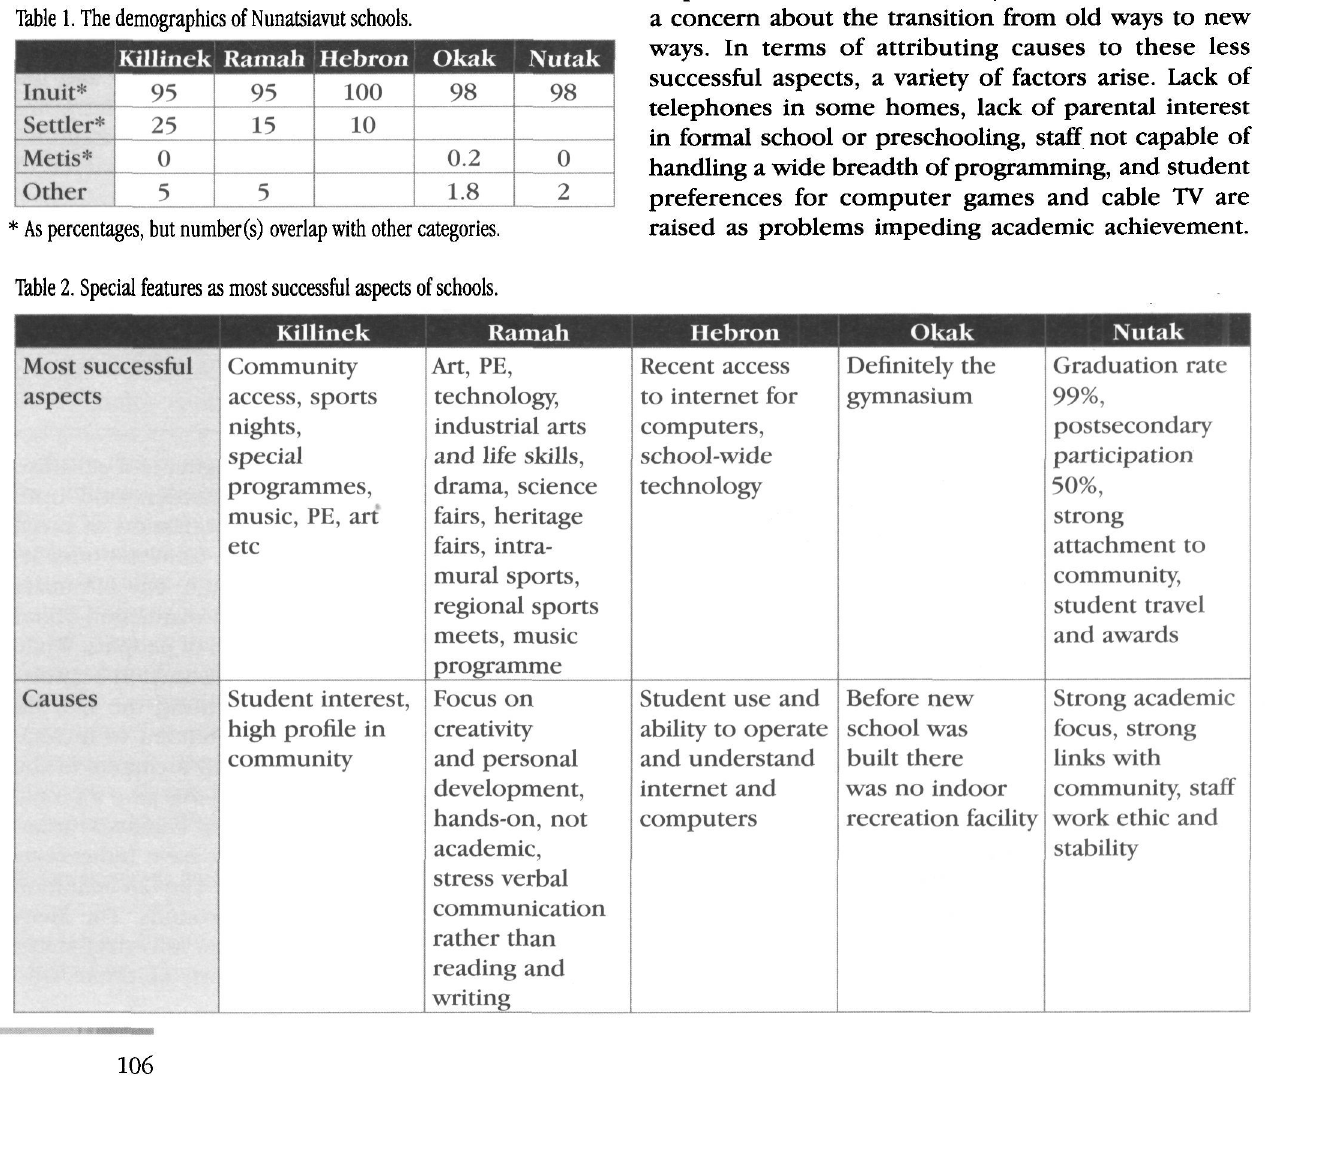
Table 1. The demographics of Nunatsiavut schools.